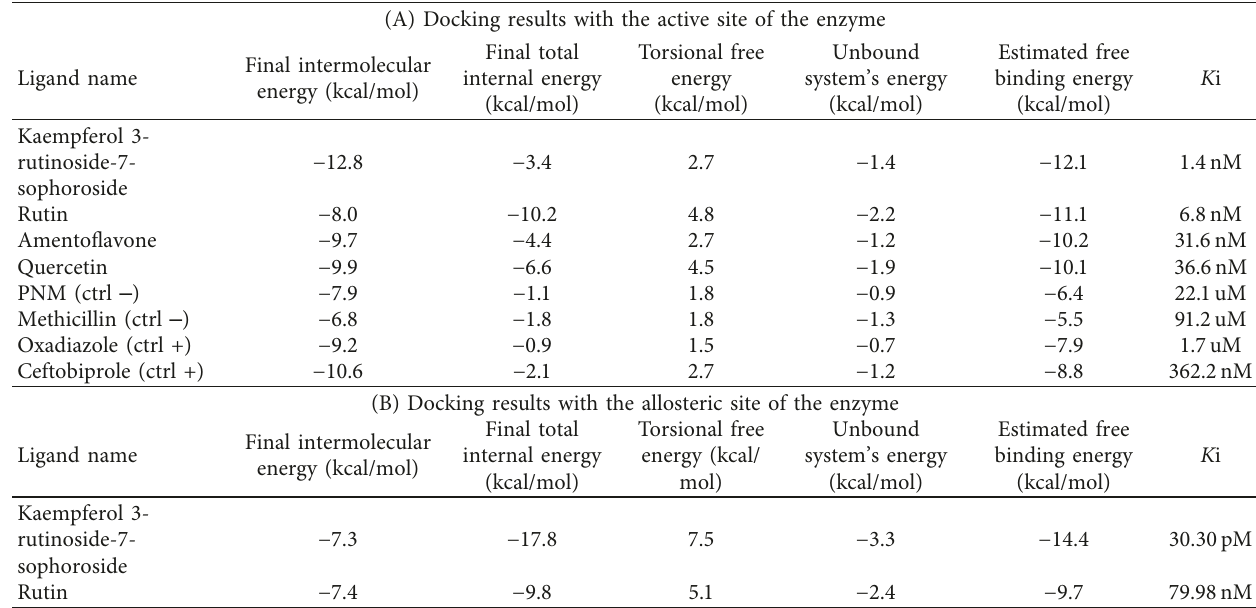
Table 1: Details of energies and inhibition constant values between top-ranked flavonoids, control compounds, and SauPBP2a achieved from the AutoDock tool. (A) Docking results with the active site of the enzyme